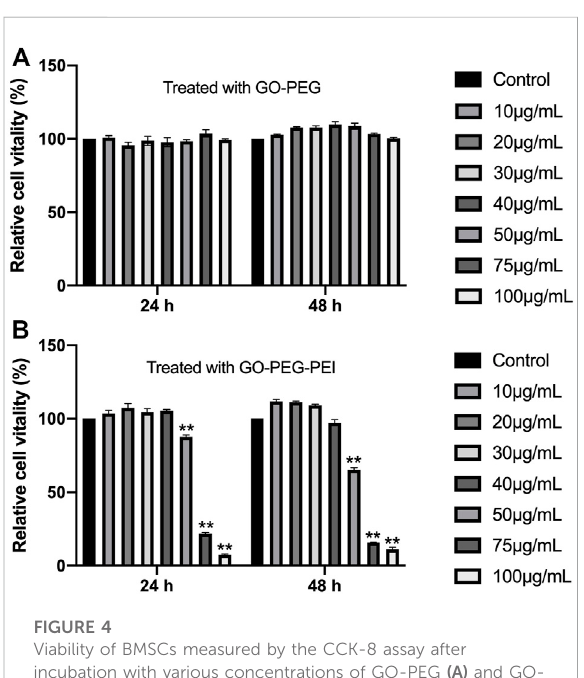
FIGURE 4 Viability of BMSCs measured by the CCK-8 assay after incubation with various concentrations of GO-PEG (A) and GO- PEG-PEI (B) for 24 and 48 h. ** p < 0.01.